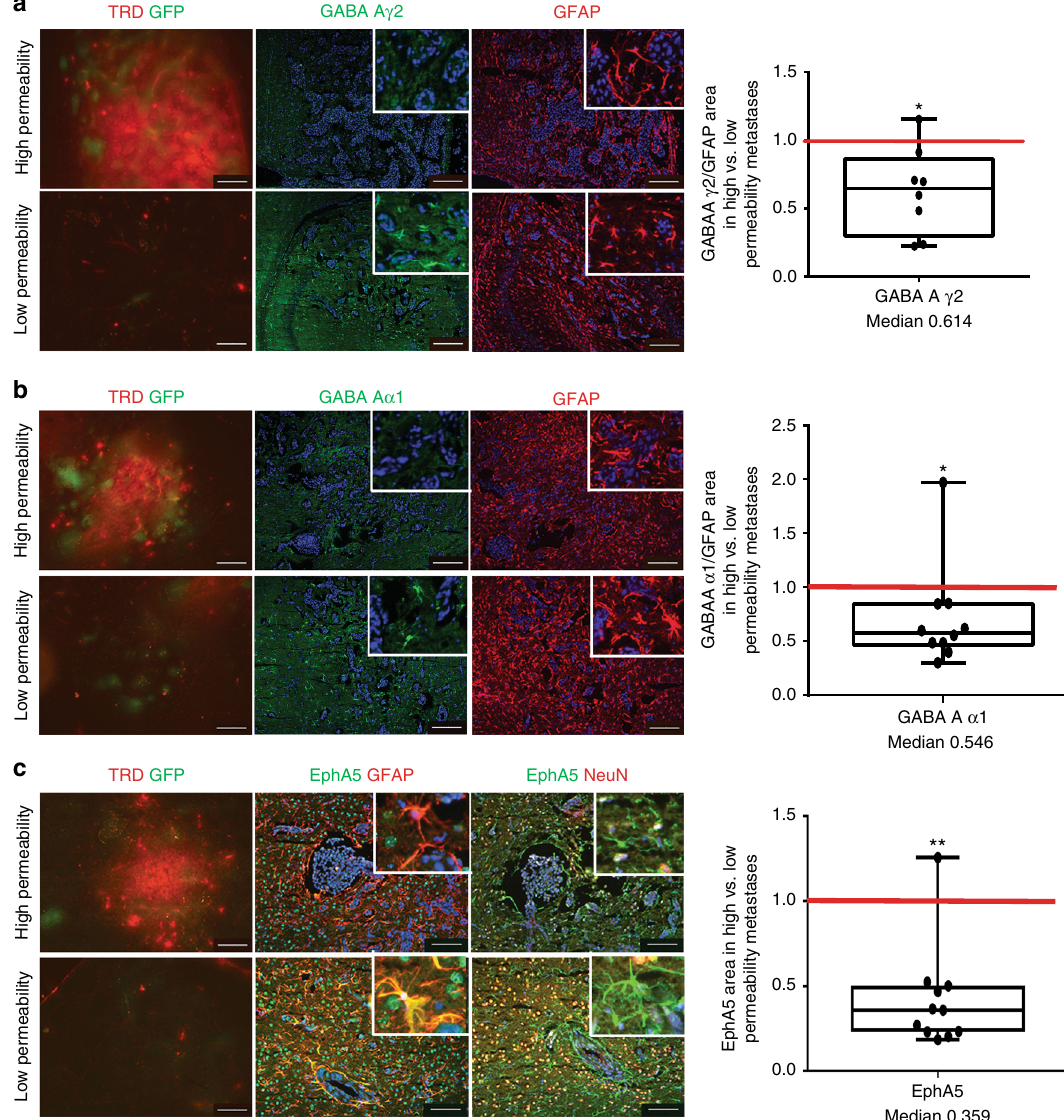
Fig. 2 Validation of three differentially expressed microenvironmental genes at the protein level. a – c Using an independent cohort of mice harboring GFP + 231-BR brain metastases, metastases were identi fi ed in H&E stained step sections, and those distinctly low and high in permeability to TRD identi fi ed by red fl uorescence exudation. Sections in between the H&E and TRD markers were used for immuno fl uorescence (IF) staining. Examples of TRD exudation with IF staining in the adjacent sections for the protein of interest and the cell source are shown. For each metastasis of known permeability, the area of IF signal for a protein was normalized to the area of staining for the brain cell type(s) in which it was expressed; the ratio of staining intensity in all highly permeable/low permeable metastases in each mouse brain is shown as a single dot on the graph to the right. The red line at unity would indicate no trend in highly/poorly permeable metastases. a Representative staining for GABA A γ 2 (green), and GFAP (red) as an activated astrocytic marker for the surrounding neuroin fl ammatory response; DAPI stained nuclei were blue in all sections. Insets: image magni fi cation. GABA A γ 2 staining intensity was normalized to GFAP intensity, and was compiled as a ratio of highly/poorly permeable metastases in a single mouse brain, represented on the graph as a dot. Median = 0.614 ( n = 8). b A second differentially expressed GABA A receptor protein, A α 1. Median = 0.546 ( n = 10). c Similar staining for Ephrin receptor EphA5, except that expression was documented in both GFAP + astrocytes and NeuN + neurons. EphA5 in highly/poorly permeable metastases, median = 0.359 ( n = 11). From ( a ) to ( c ): graphs represent the median, the interquartile range (box) and the min/max values (error bars). Wilcoxon matched-pairs signed rank test, two-tailed, * P < 0.05, ** P < 0.01 (scale bar = 100 µ